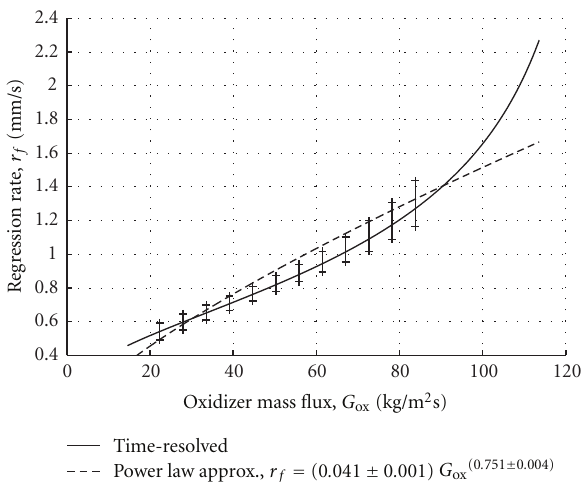
Figure 6: HTPB baseline: ensemble average, experimental data r f ( G ox ) and power law approximation, highlighting the diverging trends for G ox > 100 kg/m 2 s.